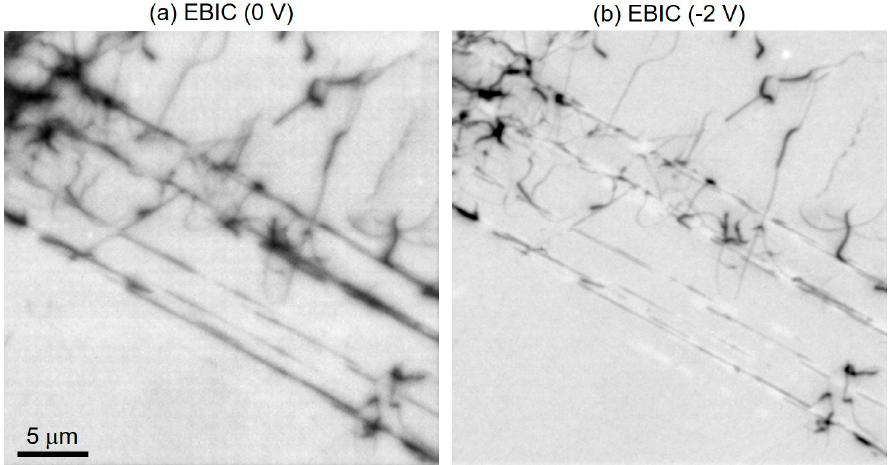
Figure 3. Room-temperature EBIC images of dislocations in (111) SrTiO 3 taken at different bias voltages. ( a ) 0 V; ( b ) − 2 V. ( a ) 0 V; ( b ) − 2